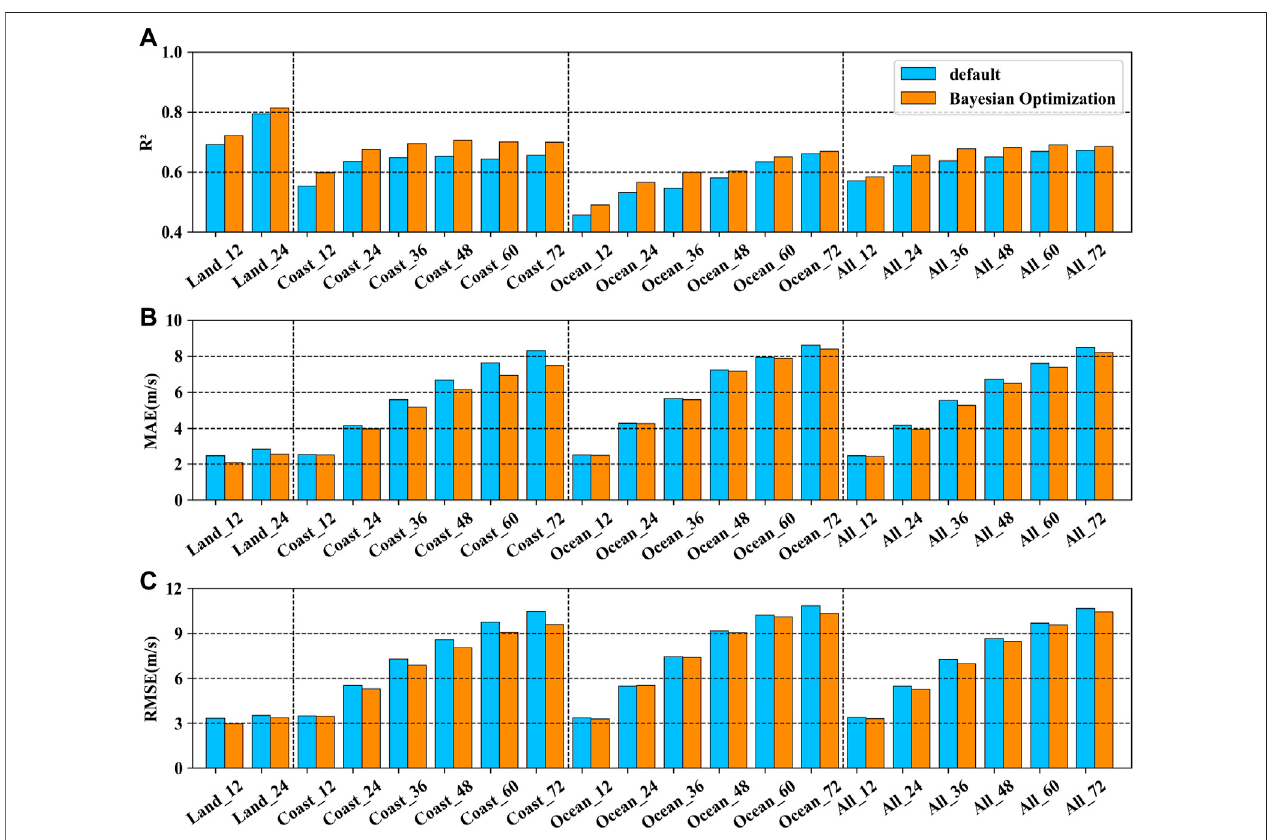
FIGURE 6 | Performance comparison between the GBRT model with the default hyperparameters and Bayesian optimized GBRT model in terms of (A) R 2 , (B) MAE, and (C) RMSE for TCs intensity change prediction based on the STI data. The labels of Land, Coast, Ocean, and All in the fi gures refer to TC samples over land, near the coast, over the open ocean, and all TC samples,